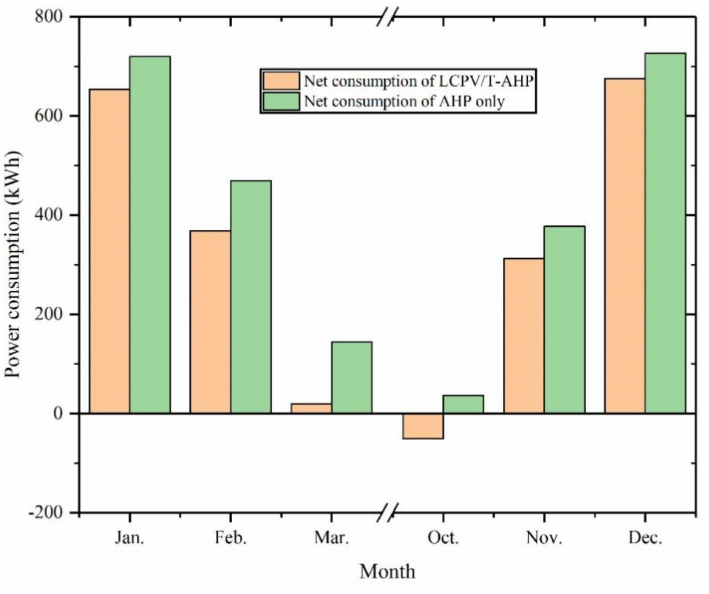
Figure 17. Power consumption comparison between the LCPV/T-AHP system and the AHP only